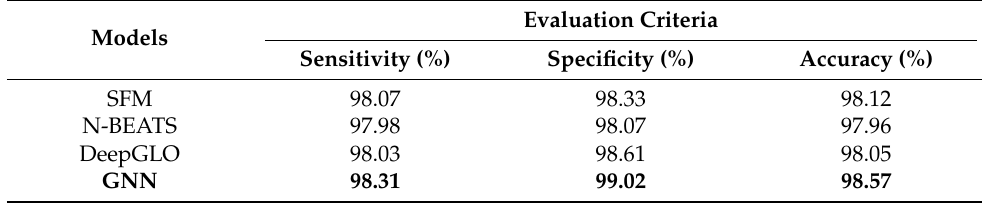
Table 4. Model experiments in different